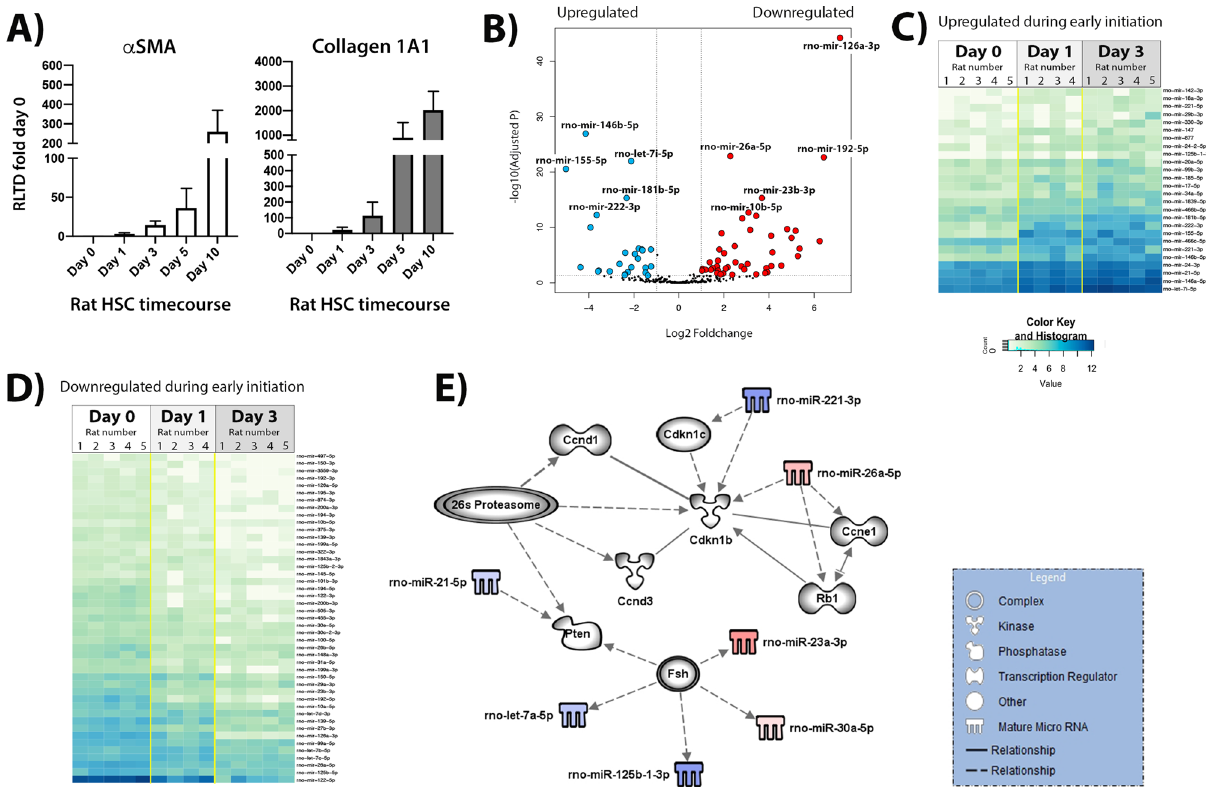
Figure 4. Differential expression of rat HSC activation during the initiation stage. ( A ) Quantitative PCR carried out on time-course cDNA isolated from of rat HSC preps used in the study showing αSMA transcript levels in left panel and Collagen1A1 in right panel. ( B ) Volcano plot of the comparison between the quiescent HSC (day 0, n = 5) and day 3 HSC (initiation of activation, day 3, n = 5). In blue—differentially under-expressed miRNA in day 0; in red—differentially over-expressed miRNA in day 0 (p-adjusted < 0.05 and foldchange > 1). ( C ) Heatmap of the 26 significant under-expressed miRNA in day 0 when compared to day 3, p-adjusted < 0.05. ( D ) Heatmap of the 45 significant miRNA over-expressed in day 0 when compared to day 3, p-adjusted < 0.05. ( E ) Biological networks of the differentially expressed miRNA. In blue and red, under and over-expressed miRNA, respectively. Shadowed in grey are molecules related to miRNA, as displayed on the legend. Lines represent different relationships between the molecules and